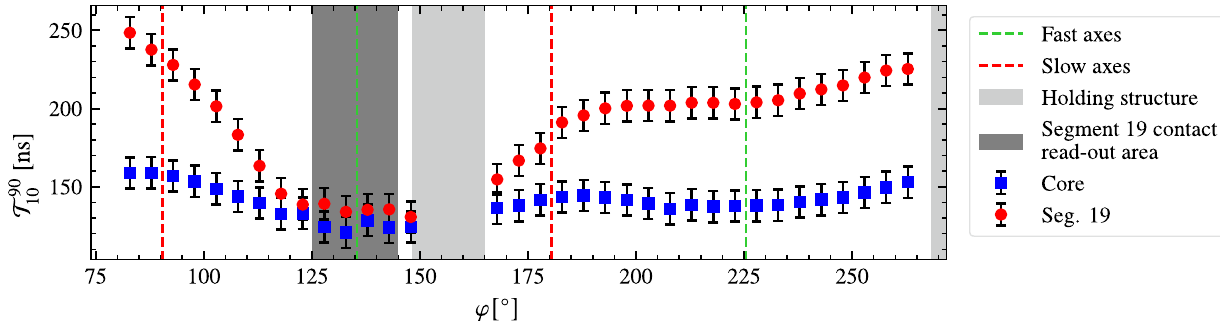
Fig. 23 Fitted means of the distribution of T 90 for the core and segment 19 of events induced by alphas from AST. The error bars indicate 10 systematic uncertainties due to the slightly fluctuating temperature of the detector in GALATEA [23]